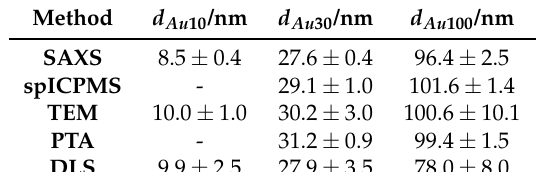
Table 1. Number weighted mean diameters of samples. Above the double line results acquired by methods measuring the inorganic core are shown. Below this line results obtained by techniques with access to hydrodynamic radius are depicted.